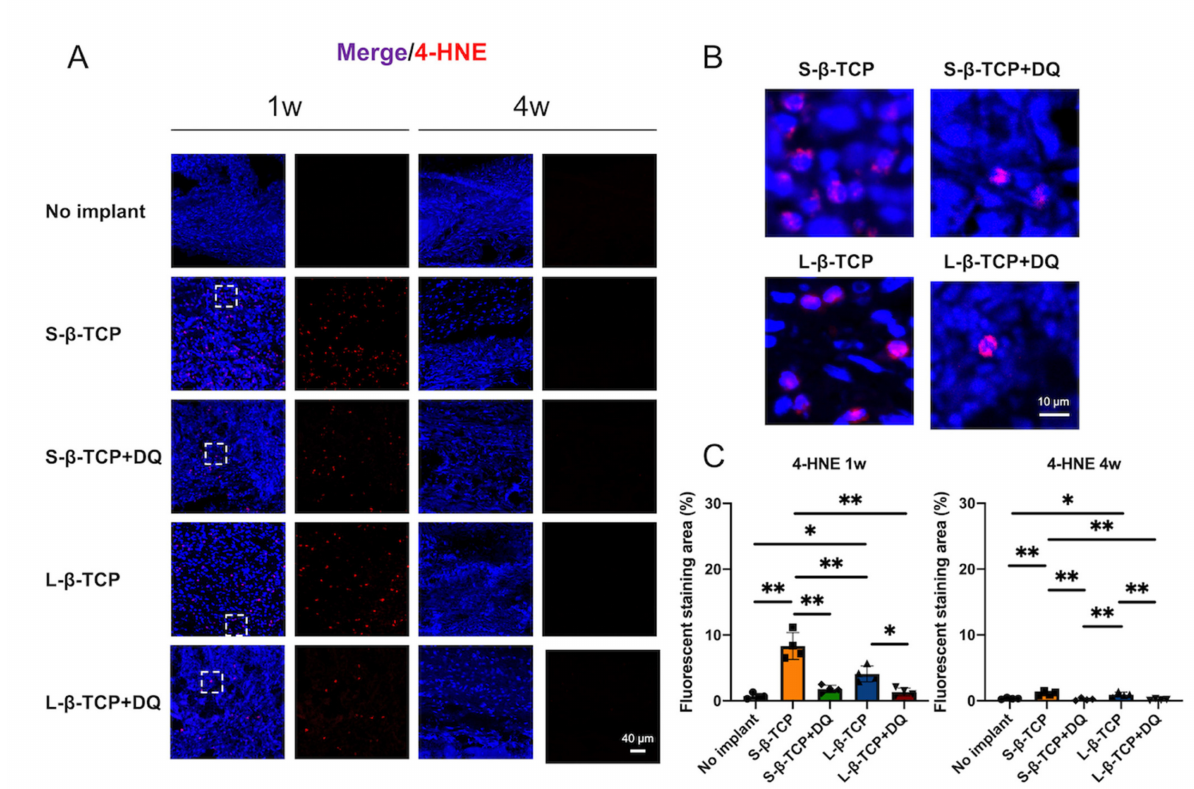
Figure 12. Evaluation of oxidation in bone defects. ( A ) Immunofluorescent images stained with 4-hydroxy-2-nonenal (4-HNE) antibody and DAPI after one and four weeks of operation (scale bar = 40 µ m). Broken squares represent areas magnified in ( B ); ( B ) magnified view of the areas in ( A ) (scale bar = 10 µ m); ( C ) 4-HNE quantified level at ROI in the bone defect. 4-HNE-positive area against nucleus area. Mean with SD ( n = 4). * p < 0.05, ** p < 0.01: One-way ANOVA analysis with Tukey–Kramer method as post hoc